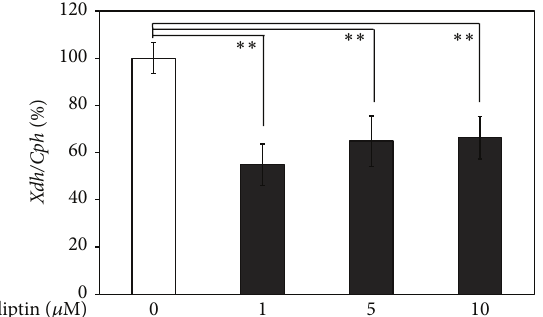
Figure 4: Effects of teneligliptin on Xdh expression in 3T3-L1 adipocytes. Serum-starved 3T3-L1 adipocytes were treated without ( ◻ ) or with teneligliptin ( ◼ ; 1, 5, and 10 𝜇 M) for 3 hours. Total RNAs extracted from all cells were used for gene expression analysis of Xdh. Levels of Cph were used for normalization of sample loading. Data are the means ± SEM of 3 independent experiments (1 experiment performed with 6 samples). Data are expressed relative to control values. ∗∗ 𝑃 < 0.01 versus control cells.